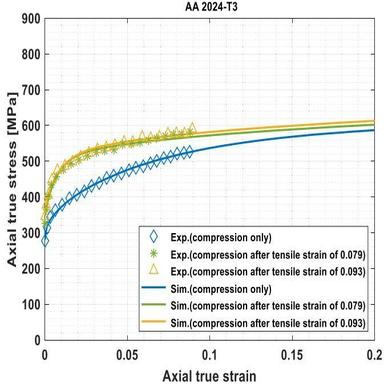
Mixed Swift-Voce hardening curves in uniaxial compression paths for AA 2024-T3.